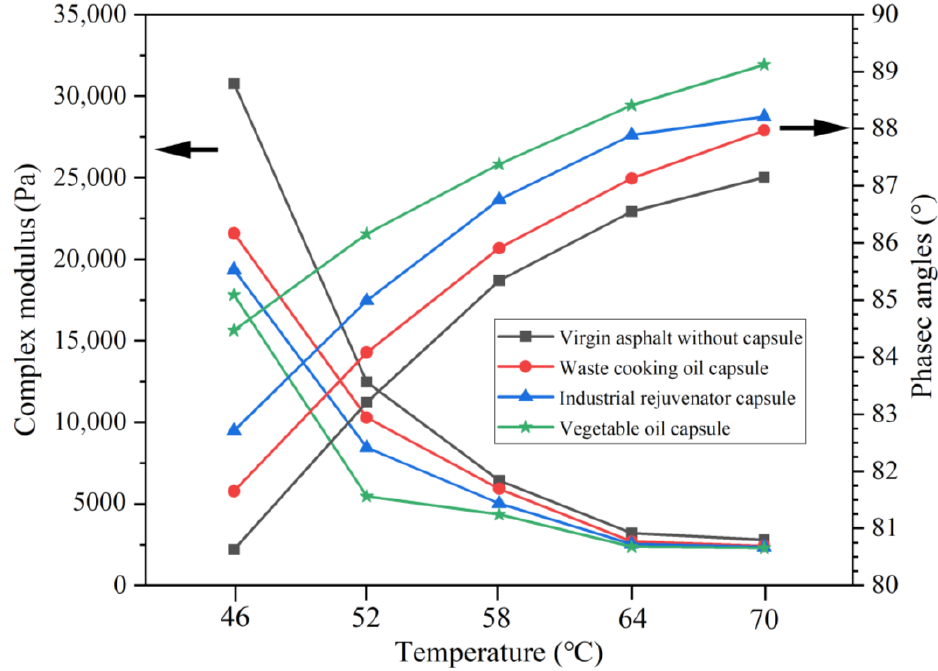
Figure 14. The G* and δ of the extracted asphalt binders within asphalt mixtures containing different capsules after loading at 1.4 MPa. capsules after loading at 1.4